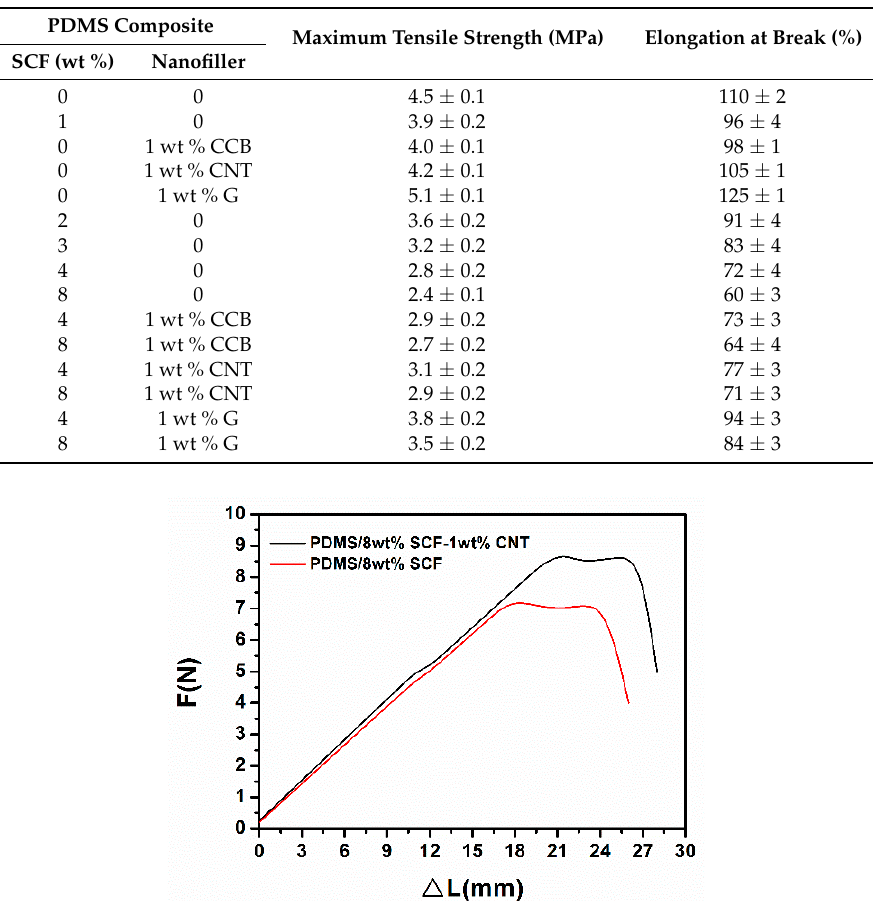
Figure 7. The tensile curve of PDMS/SCF (8 wt %) and PDMS/SCF (8 wt %)-CNT (1 wt %) samples.